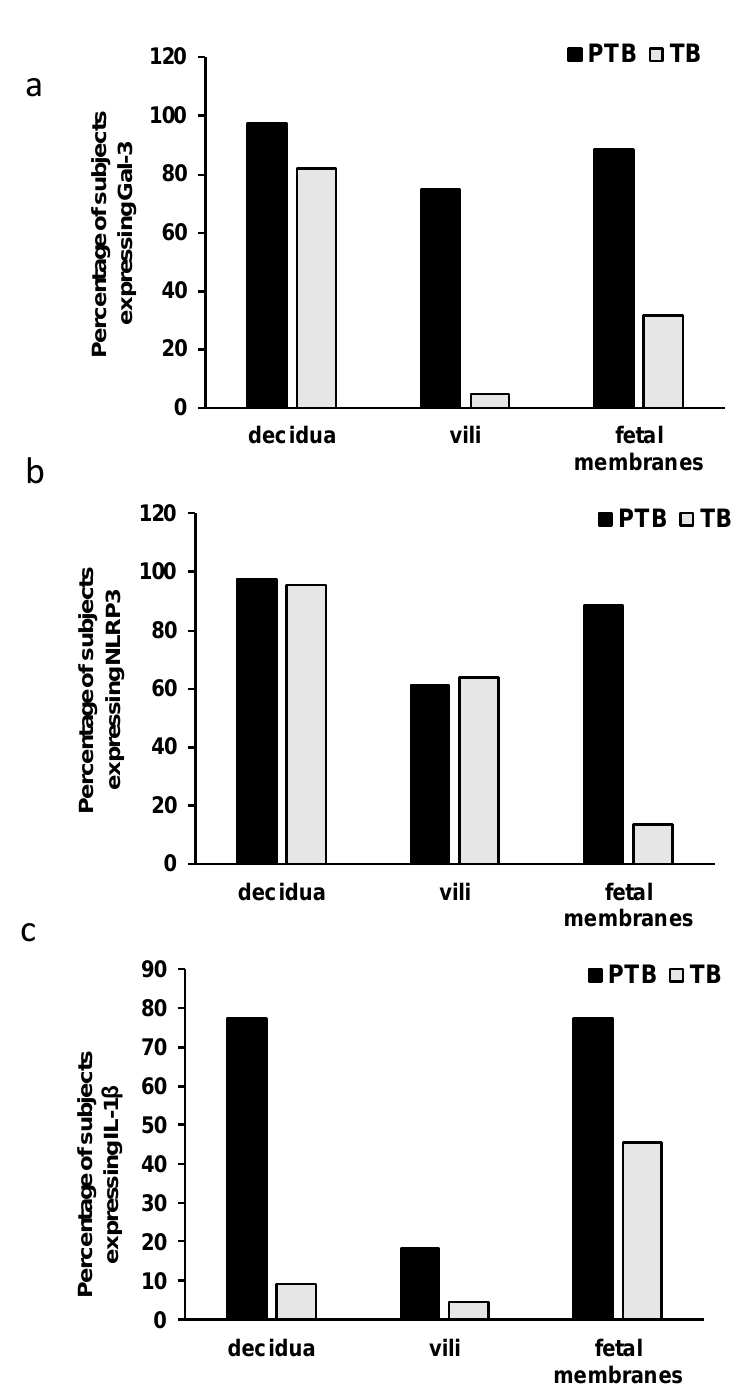
Figure 3. Incidence of Gal-3 ( a ), NLRP3 ( b ), and IL-1 β ( c ) in tissues of decidua, villi, and fetal membranes obtained during preterm (PTB) and term (TB) births.